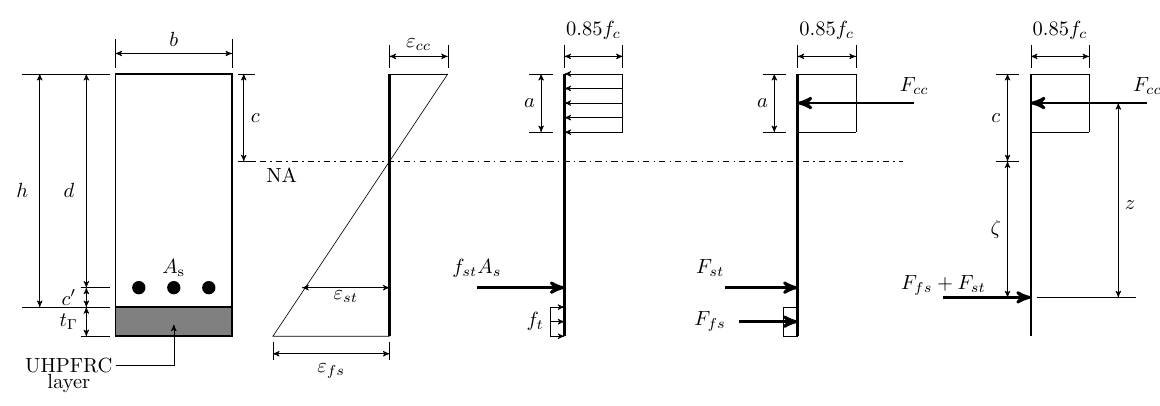
Figure 2. Stress block geometries for the for the proposed approach considered with tensile capacity of UHPFRC layer due to steel fibres considered